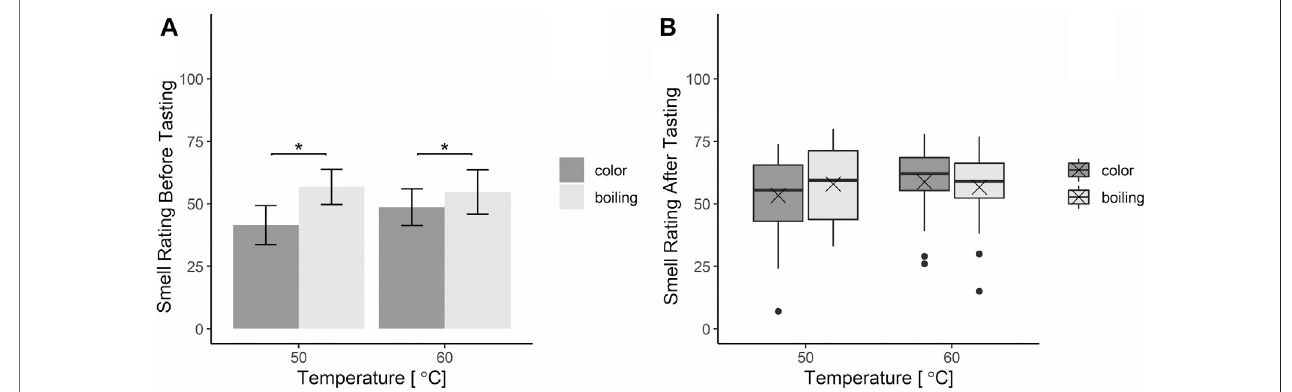
FIGURE 5 | (A) Smell ratings before tasting and (B) after tasting.